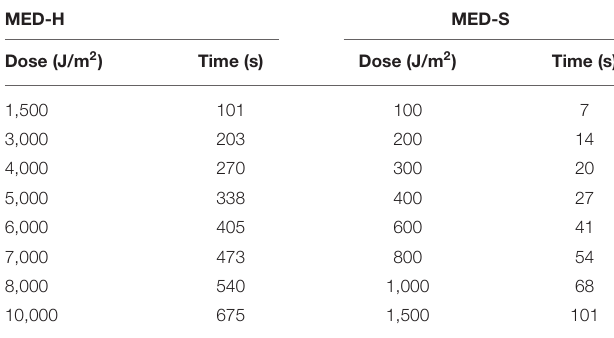
irradiation were evaluated after 24 h, always by the same two